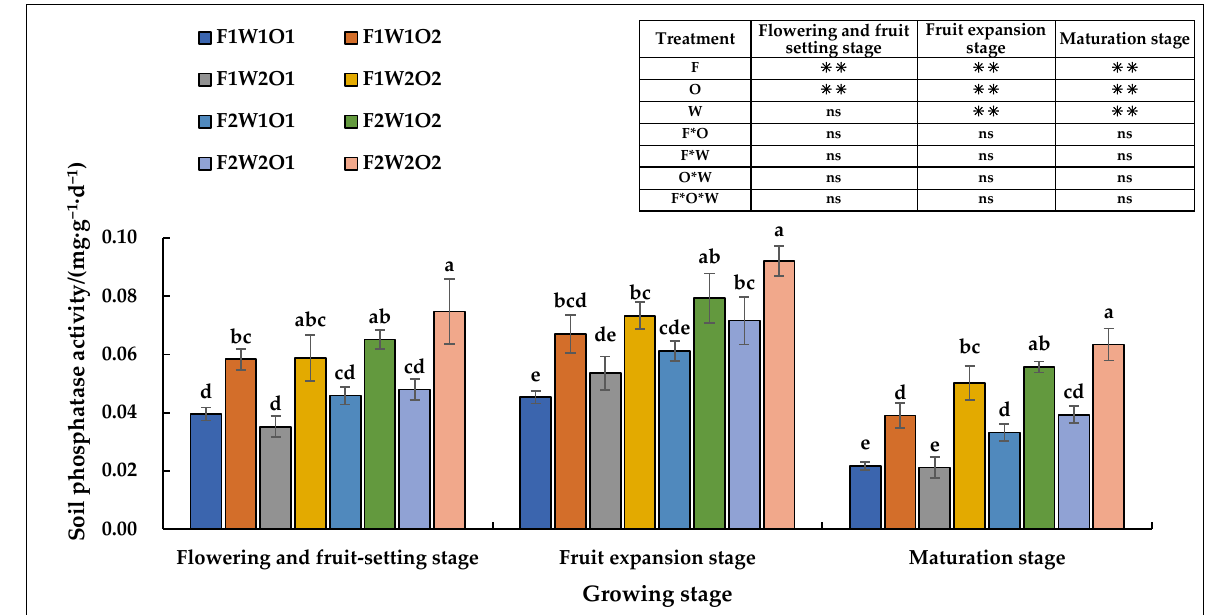
Figure 5. Analysis of variance of soil phosphatase activity in the tomato root zone under different treatments. Note: F represents the fertilizer amount, O represents the oxygen amount, W represents the irrigation amount. Different letters indicate significant differences at the level of p < 0.05. * p < 0.05. ** p < 0.01. ns, not significant at p < 0.05.